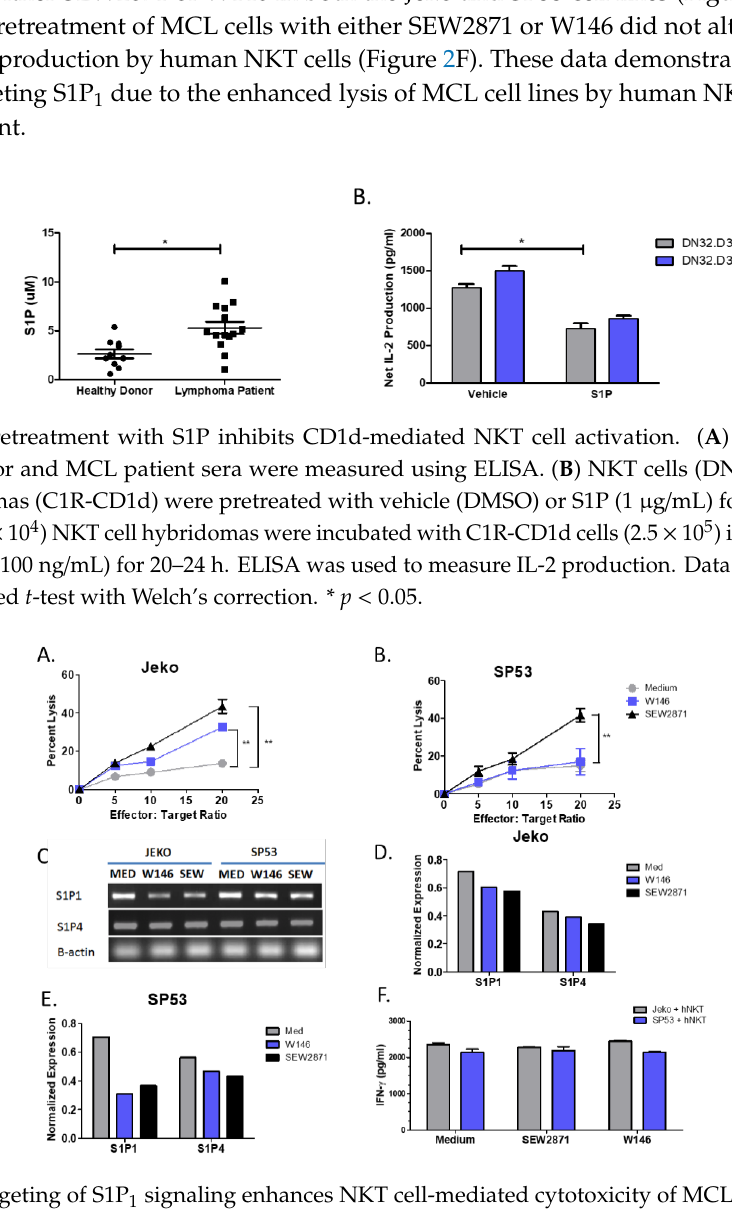
Figure 2. Targeting of S1P 1 signaling enhances NKT cell-mediated cytotoxicity of MCL. ( A ) Jeko and ( B ) SP53 cells were incubated with 10 µM SEW2871 or W146 for 72 h, washed, and co-cultured with primary NKT cells at the indicated ratios in the presence of α-GalCer (100 ng/mL) for 24 h and NKT cell mediated cell lysis was assessed by standard 51 Cr-release assay. ( C ) MCL cell lines express S1P